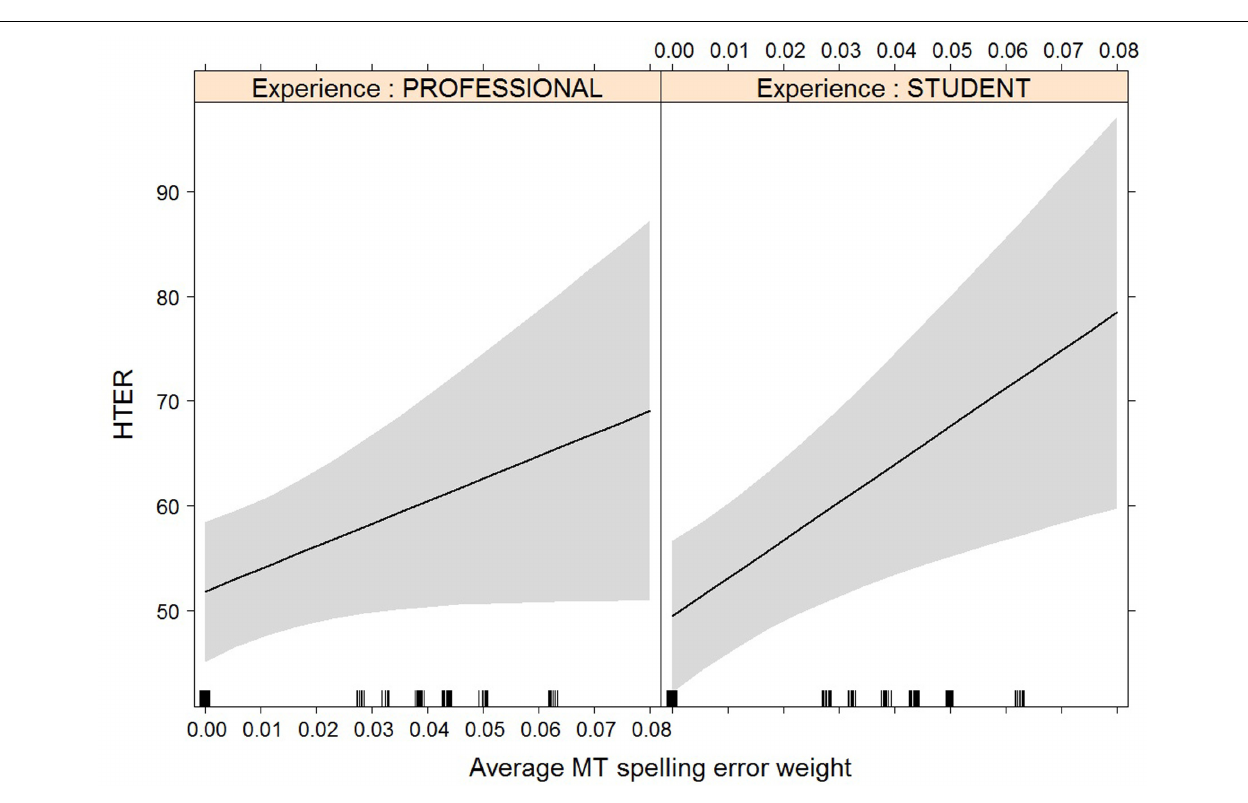
FIGURE 10 | Effect plot of MT spelling error weight on HTER. Only the interaction effect is significant: the average HTER for students increases more heavily than that of professional translators with an increase in MT spelling error